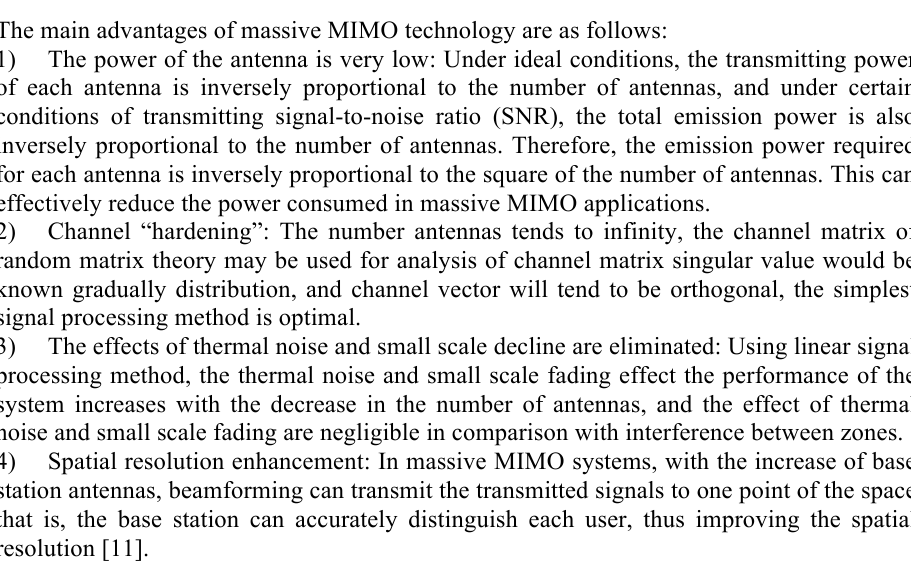
Fig. 4. Application scenarios of massive multi-antenna MIMO